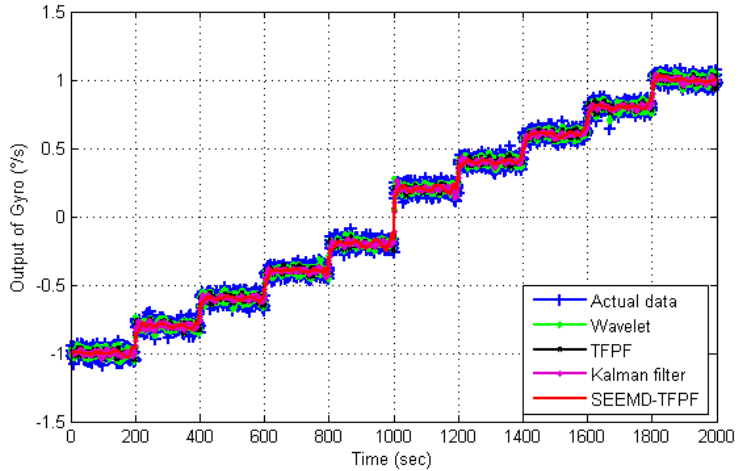
Figure 9. Comparison results of rotation signal de-noising by using different methods.